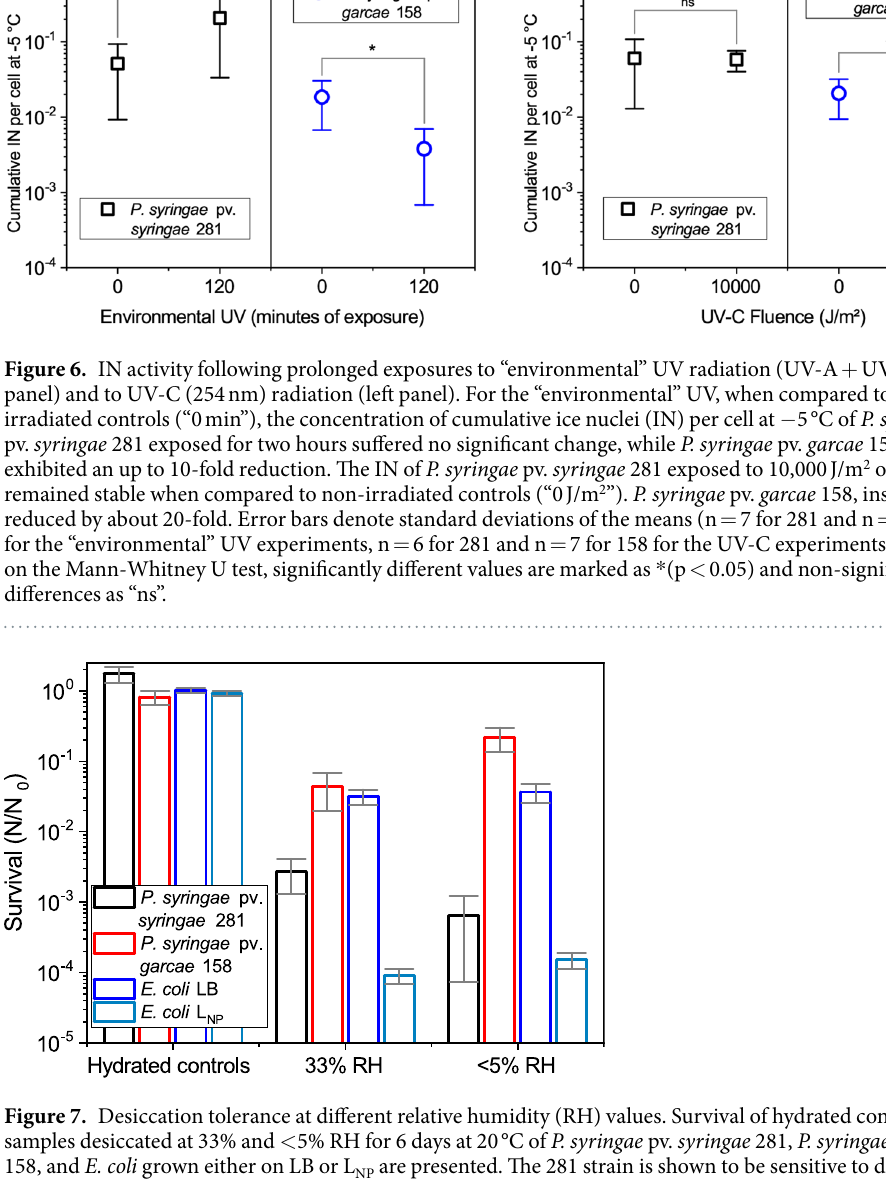
The IN activities of the desiccated P. syringae strains were strikingly different (Fig. 8). After being resuspended from the RH 33% and RH < 5% treatments, the 281 strain presented a reduced mean cumulative nuclei concen- tration of about 3–4 × 10 − 3 per cell at − 5 °C. Probably, this can be attributed to the disruption of the cells’ outer membranes where the ice nucleation protein clusters lie. Its hydrated controls remained at typical values for these cultures, at 1.1 ± 1.0 × 10 − 1 . However, the IN concentrations for the 158 strain, which are normally similar to those of 281 (see Fig. 1), were lower by 10 3 –10 4 times, even for hydrated cells that kept most of their viability. Its mean measured IN activities (concentration per cell at − 5 °C) ranged from 1 × 10 − 4 to 9 × 10 − 6 , after the 6-day period at 20 °C. Since Pseudomonas IN are known to be heat-sensitive, the temperature was suspected to play a role in this decline, so new experiments were performed storing the 158 strain samples at 4 °C. Survival was very similar at these conditions, and a substantially increased maintenance of IN at the hydrated control and RH 33% samples was observed, while the RH < 5% treatment remained mostly identical (Supplementary Fig. S1). Yet, these values were still lower than the typical IN concentration for this strain (Fig. 1).